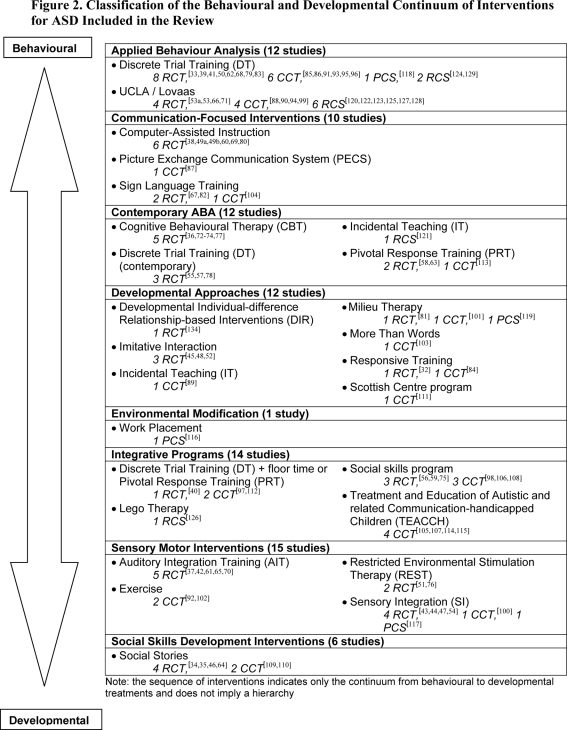
Classification of the Behavioural and Developmental Continuum of Interventions for ASD Included in the Review.